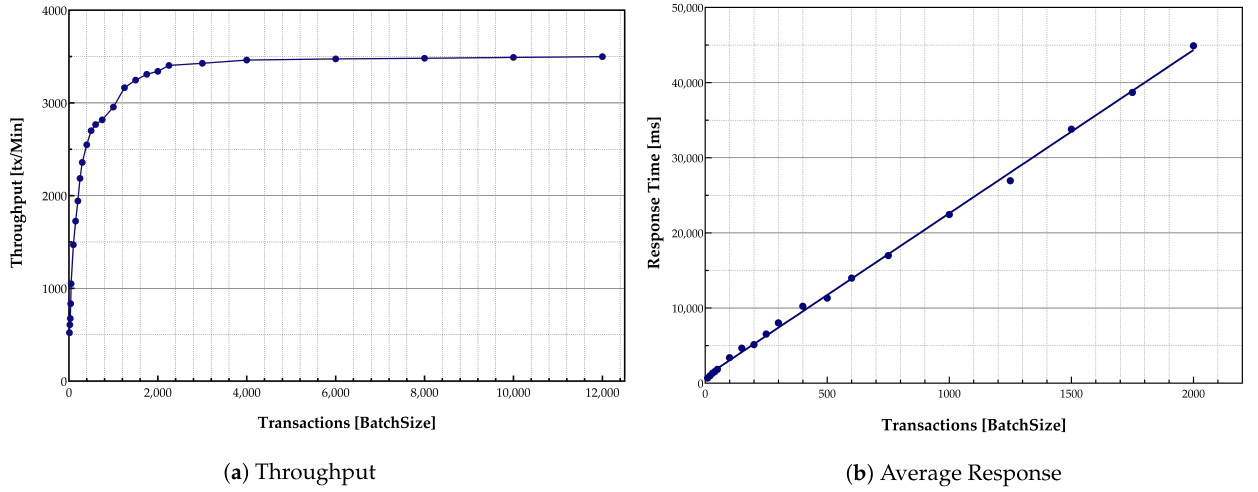
Figure 8. Effects of transaction sizes on the throughput and average response times in Desktop